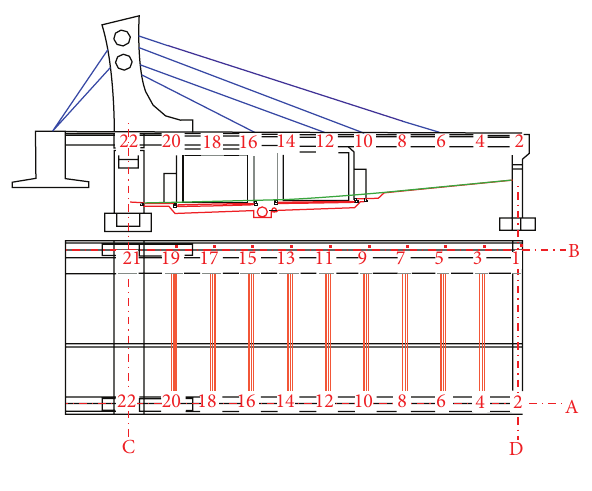
Figure 30: Measurements setup.